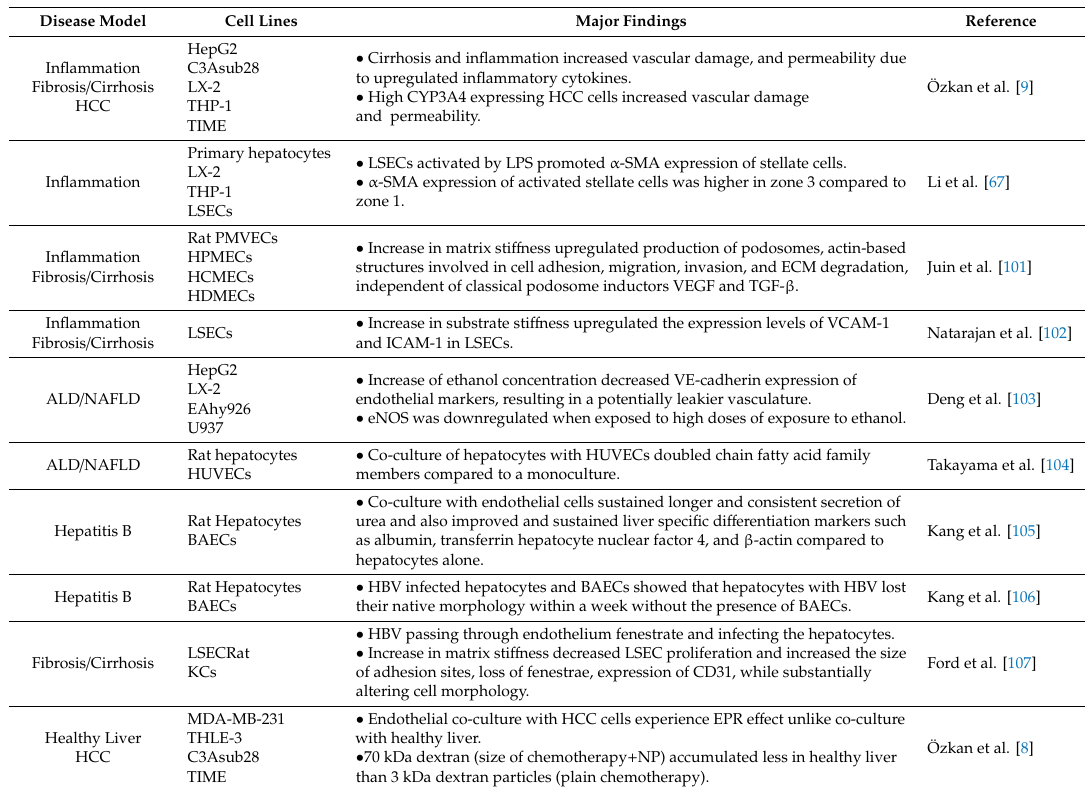
Table 1. Major findings reported in vascularized